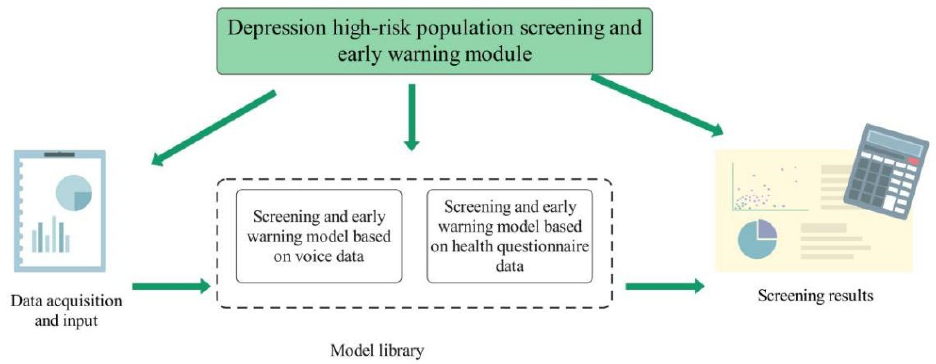
Figure 1. Scheme of the screening and early warning model.